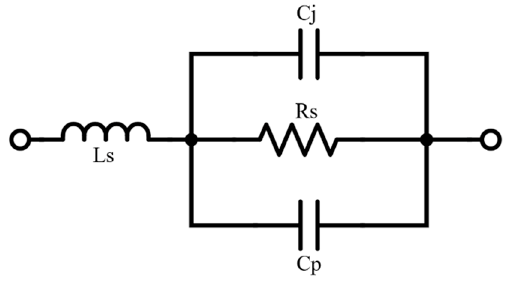
Figure 3. PIN diode equivalent model.